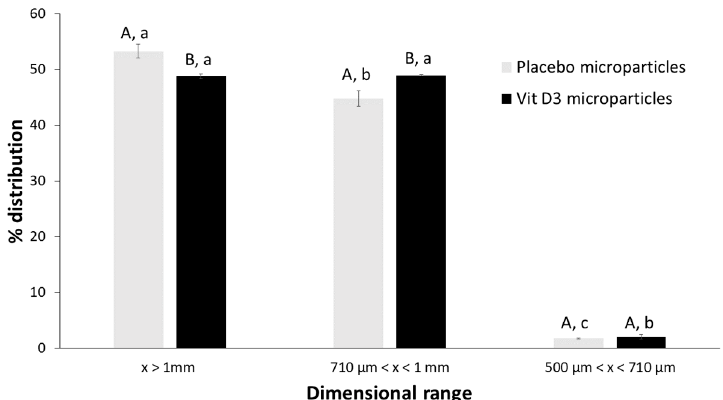
Figure 4. Particle size distribution of dried microparticles. Dissimilar capital letters over bars denote significant differences between samples within the same dimensional range ( p < 0.05); while different lowercase alphabetical characters denote significant differences among different dimensional ranges within the same sample ( p < 0.05).